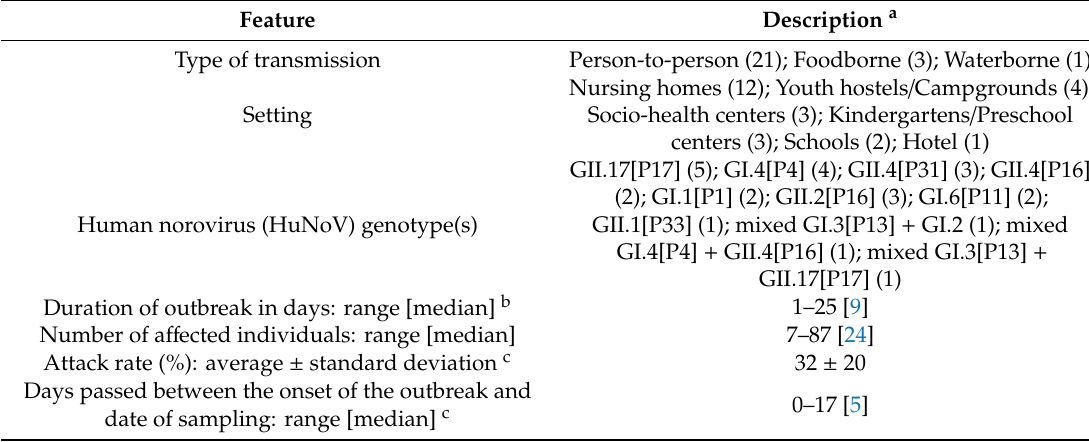
Table 1. Main epidemiological features of the 25 outbreaks used in the study.